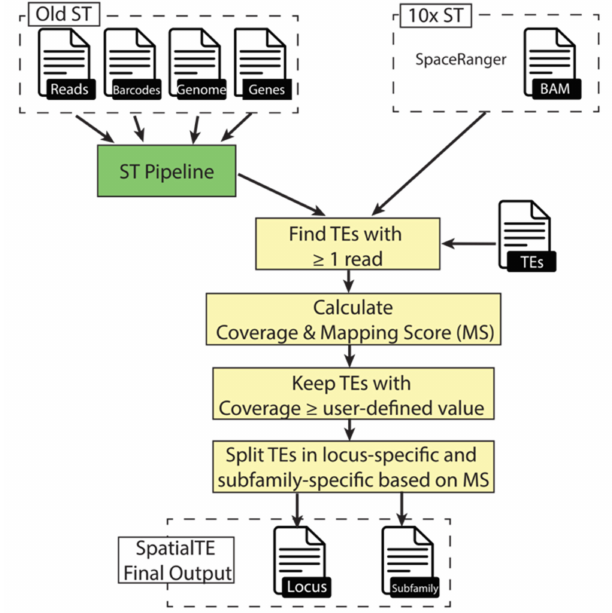
Figure 5. Workflow of SpatialTE. Dashed boxes correspond to the input files (shown with a file icon and a name) for SpatialTE according to the ST technology used (Old or 10 × ). The green box corresponds to the run of the external tool ST pipeline (which performs read alignment and identification of gene expression per spatial spot), whereas yellow boxes correspond to key processes within SpatialTE. First, TEs having at least 1 read are selected. Second, for these selected TEs two metrics are calculated: Coverage (percentage of TE bases covered by reads) and the mapping score (number of uniquely mapped reads aligned to the TE divided by the total number of reads aligned by the TE). Third, TEs can be filtered by a user-defined coverage threshold (default = 0, i.e., keep all TEs). Finally, SpatialTE generates two outputs according to the mapping score of the TEs (output files, TEs by locus and TEs by